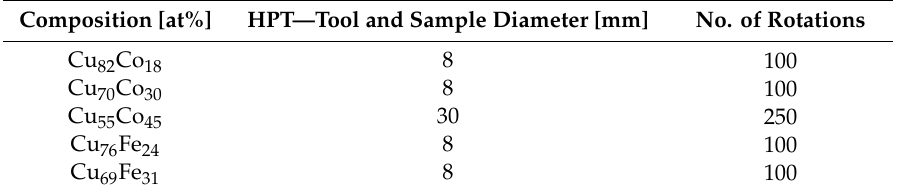
Table 1. High-pressure torsion (HPT)-processed samples, with their composition in at% and processing parameters such as HPT-tool diameter and number of